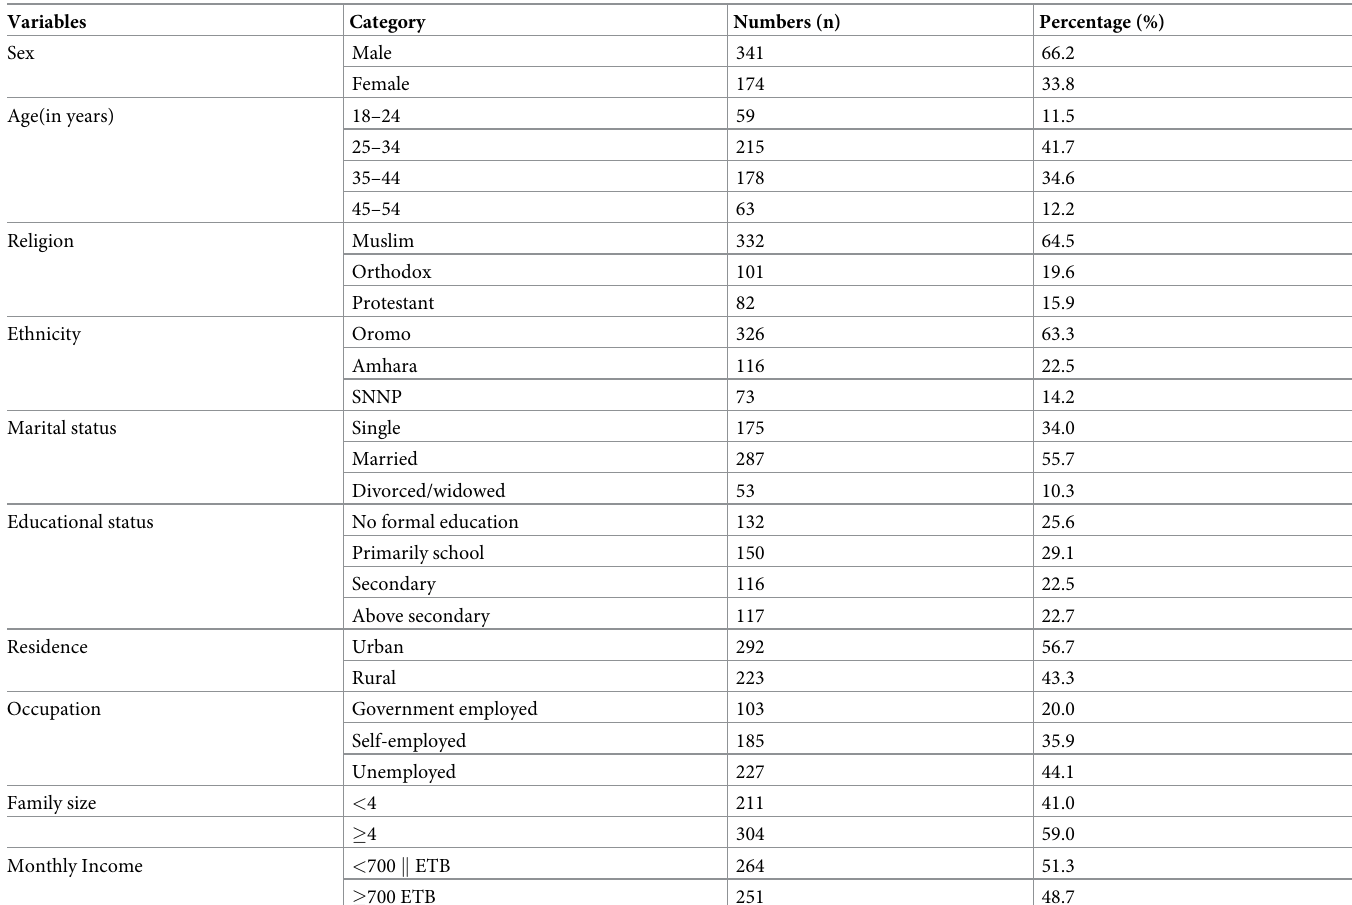
Table 1. Socio-demographic characteristic of patients with schizophrenias at southwest Ethiopia, 2019 (n =